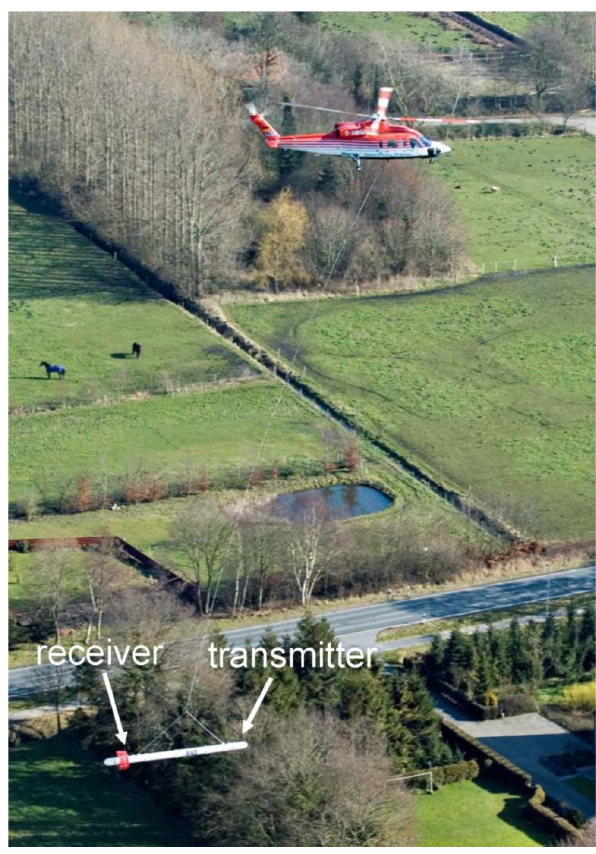
Fig. 5. The BGR helicopter-borne geophysical system.